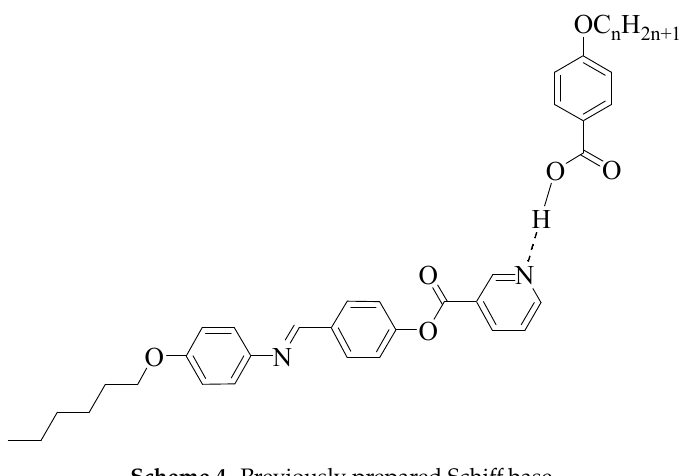
Table 2. Thermal parameters (Hartree/Particle) of both conformers of the H-bonded complexes I /An. Conformer Chair-shaped V-shaped